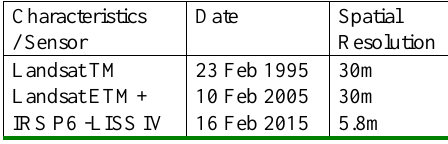
Figure 1. Study Area